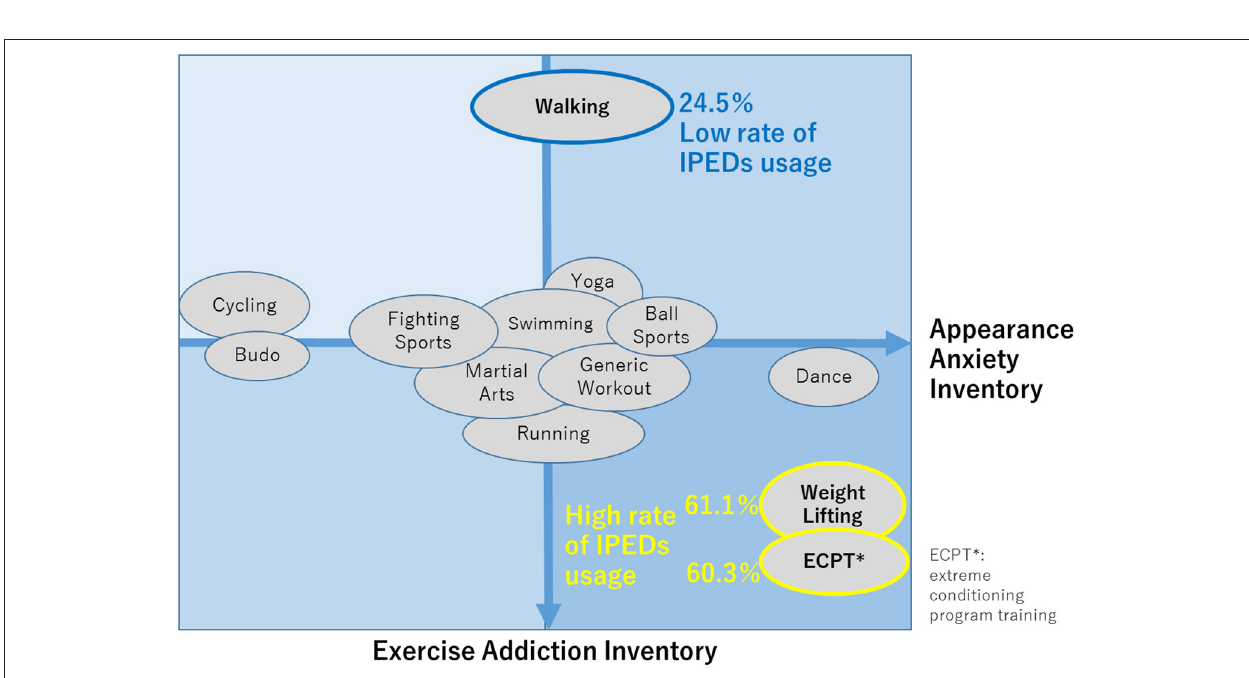
FIGURE 10 | Characteristics of each disciplines according to EAI and AAI scores. EAI, exercise addiction inventory; AAI, appearance anxiety inventory [Revised from Shibata et al. (86)].